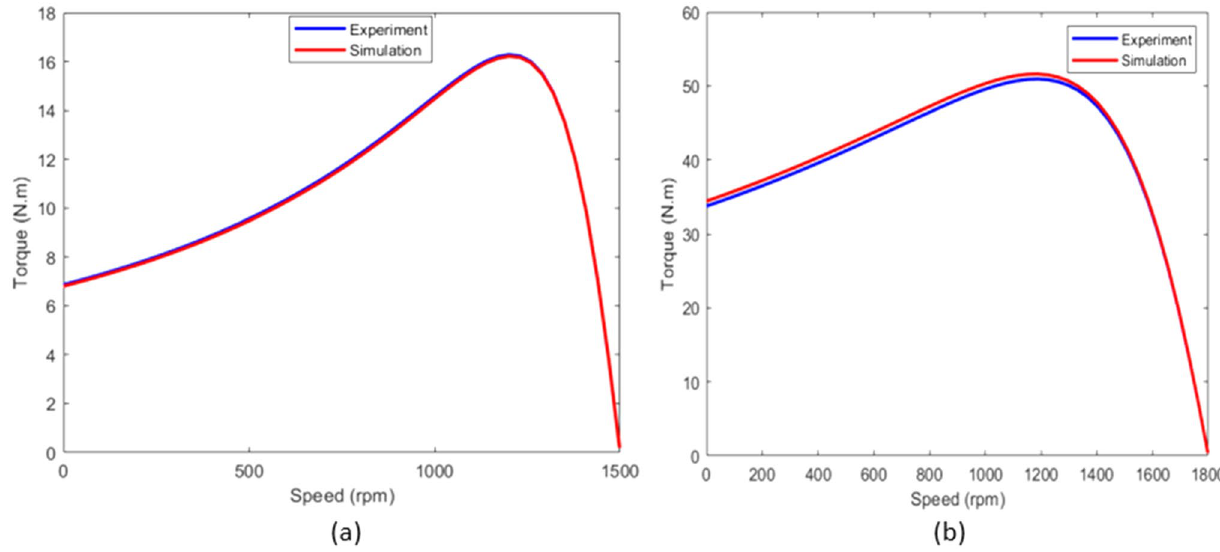
Fig. 7 Torque-speed cracteristics using experiment parameters and simulation parameters a M1, b M2